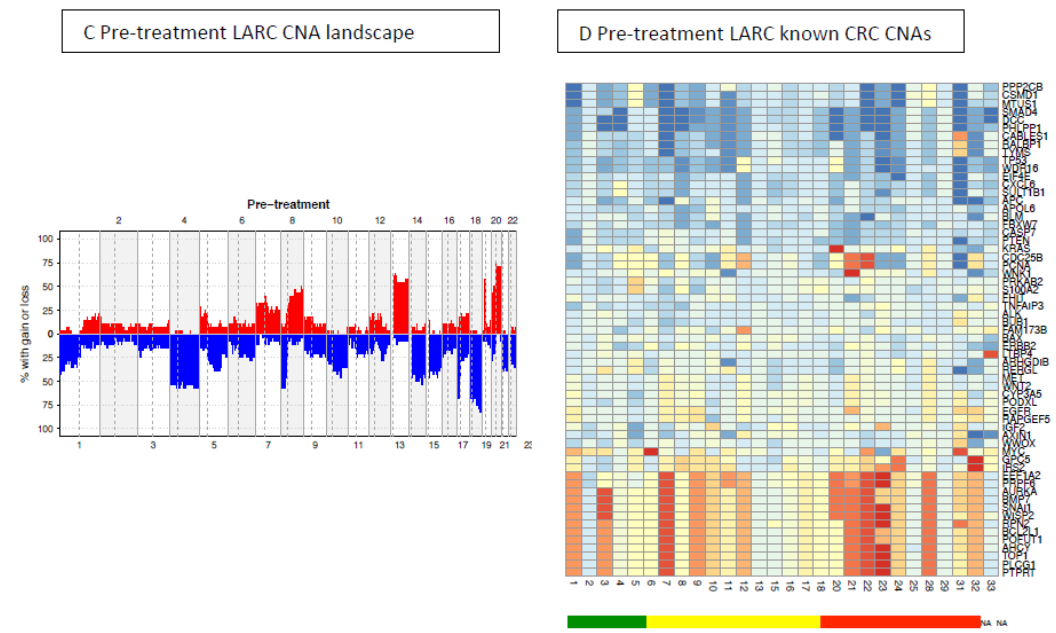
Figure 1. Project overview and pre-treatment genomic landscape. ( A ) Project overview — number of patients from whom pre-treatment, matched on-treatment, and matched resection tumour samples were collected. ( B ) Summary of genomic mutations identified in pre-treatment patient tumours by response category. Number of single nucleotide variants (SNVs), indels, overall ploidy and mutations in known colorectal cancer genes are shown. The proportion of mutations attributed to COSMIC mutational signature 1 (Sig1) and mismatch repair-associated signatures (MMRsig) are shown. ( C ) Frequency of copy number alterations (CNAs) by chromosome arm in the pre-treatment tumours. ( D ) Log 2 ratios of colorectal cancer genes known to be affected by CNA. Red indicates positive log 2 ratio (gains) and blue indicates negative log 2 ratio (losses).